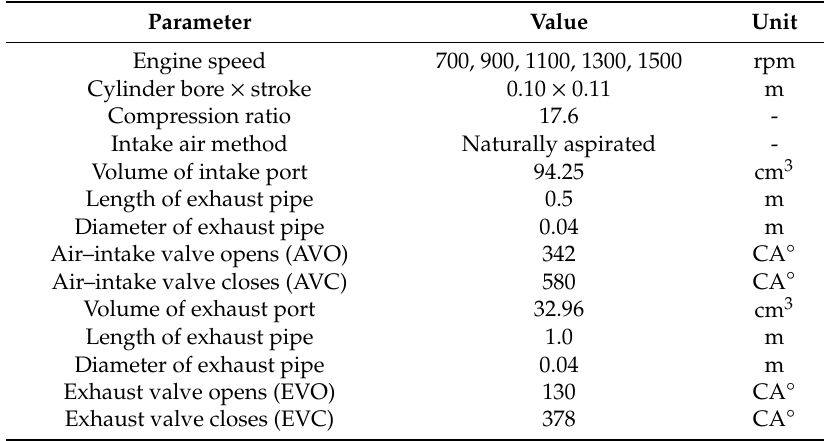
Table 1. Specifications of the experimental